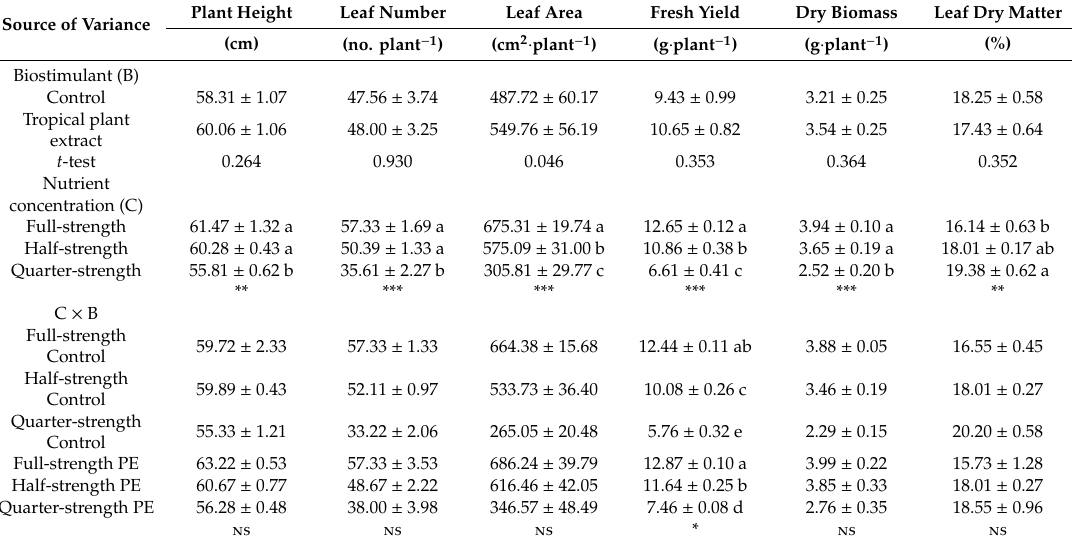
Table 1. Growth parameters, fresh yield, shoot dry biomass, and leaf dry matter percentage of hydroponically grown jute in relation to nutrient solution concentration and tropical plant extract biostimulant application. All data are expressed as mean ± error ( n =